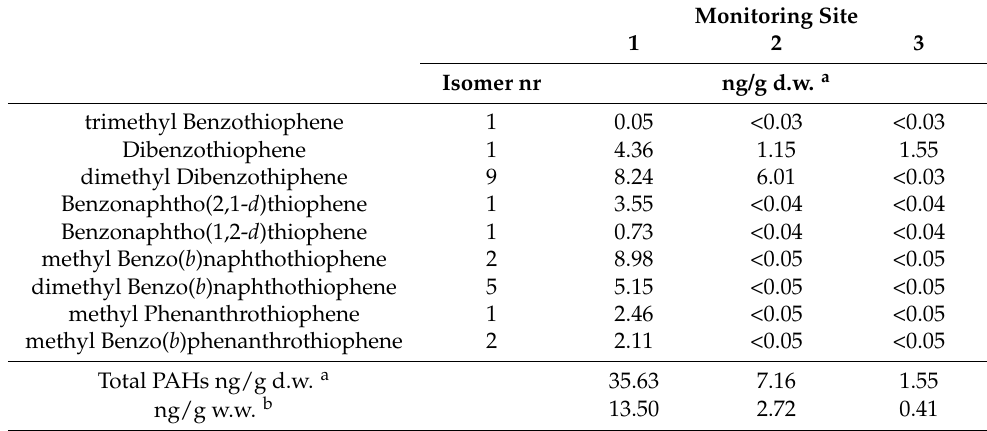
Table 3. Concentrations of PASHs parent and alkylated (expressed as ng/g honeybee